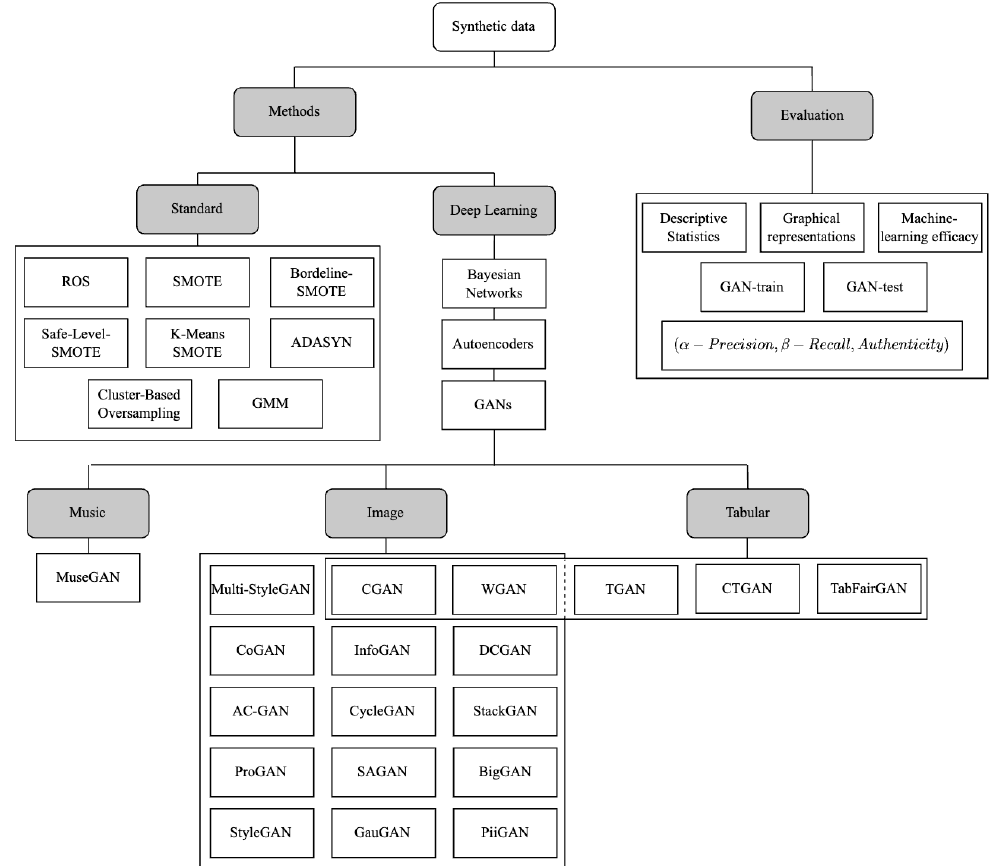
Figure 28. Organizational chart depicting several methods for the generation of synthetic samples and the evaluation techniques covered in this